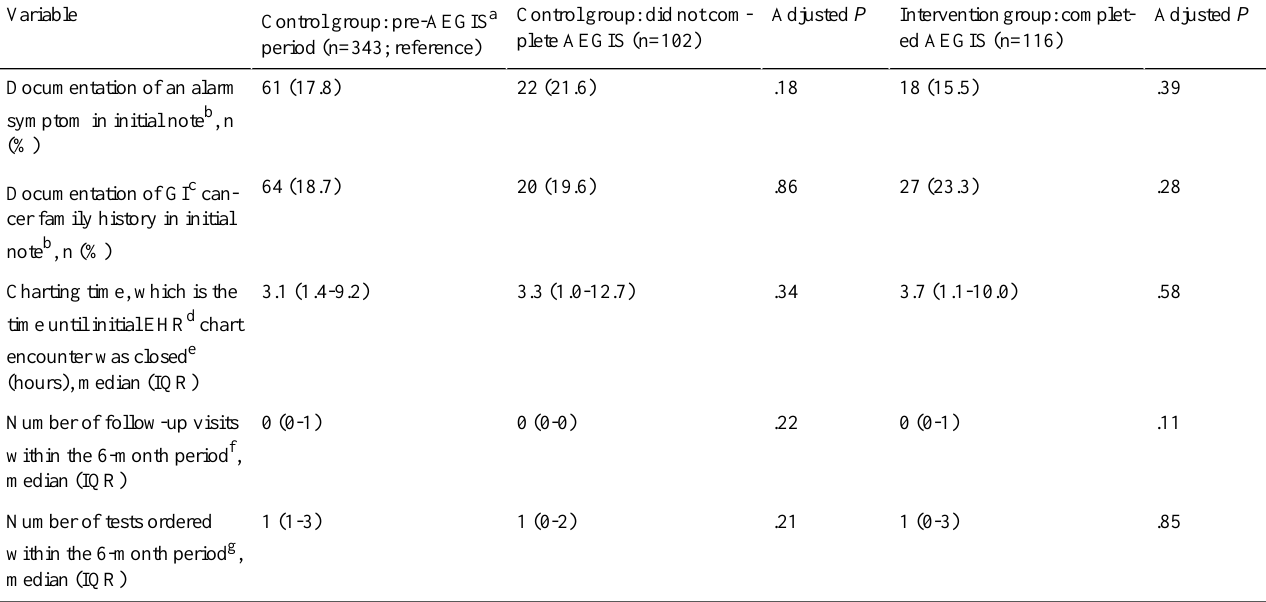
Table 3. Physician-related outcomes according to study group (N=561).